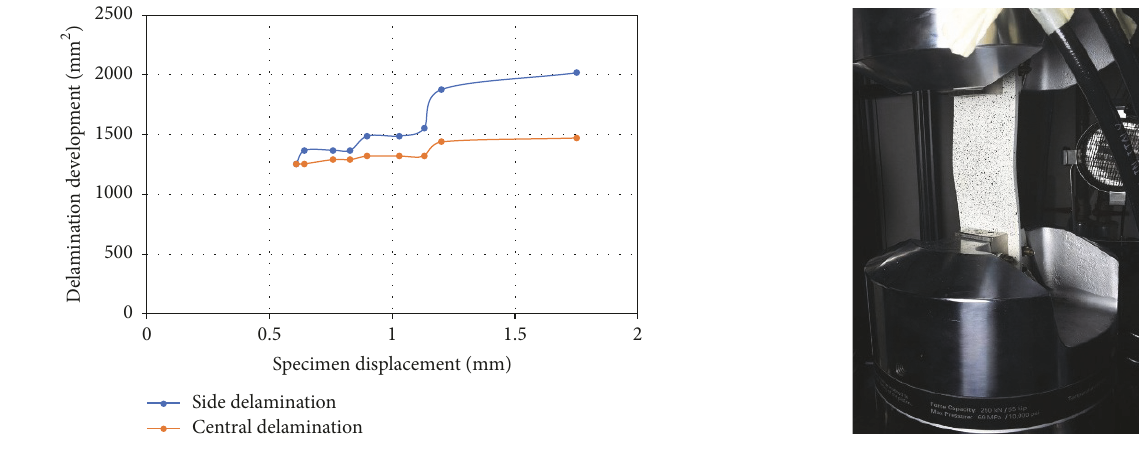
Figure 23: Delaminated area as a function of the applied compres- sive displacement, comparison between side and central delamina- tion configuration.